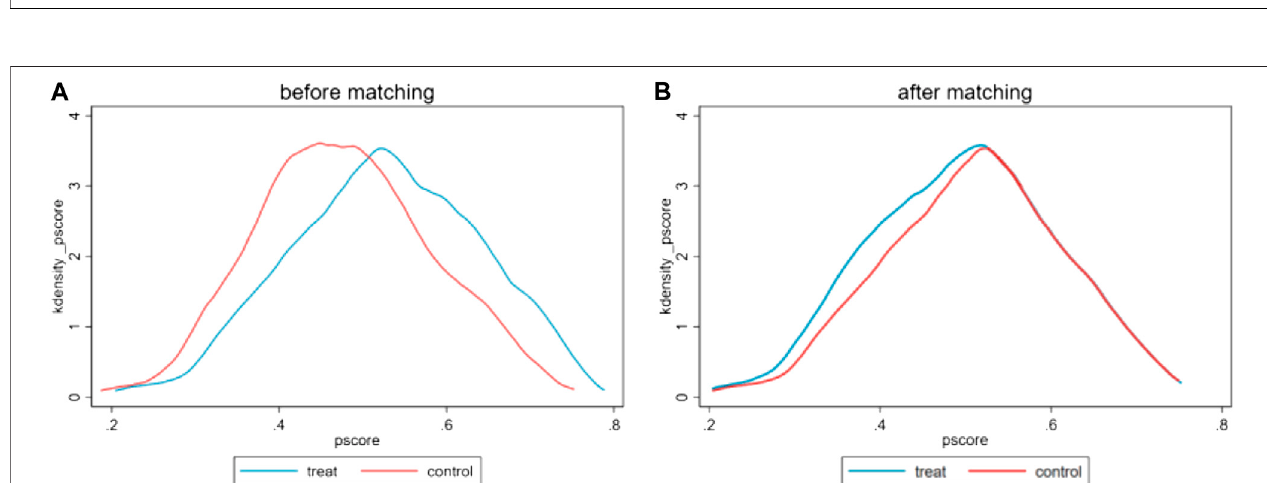
FIGURE 4 | Kernel density estimate of electricity billing. (A) Before matching; (B) After matching.